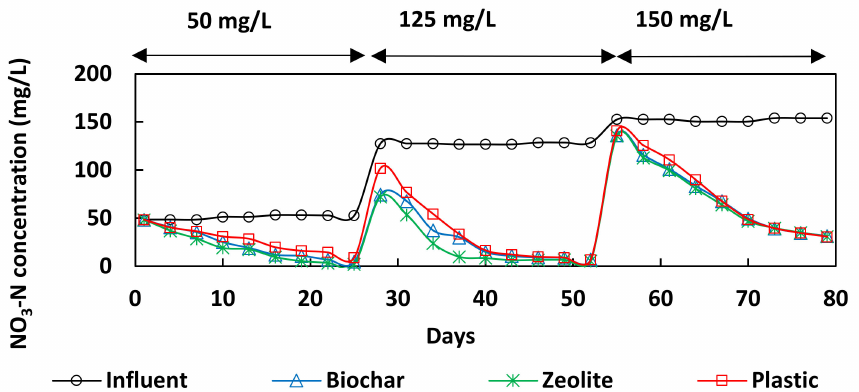
Figure 4. The NO 3 -N concentration of the influent wastewater as well as the change in NO 3 -N concentrations for the three types of media used.